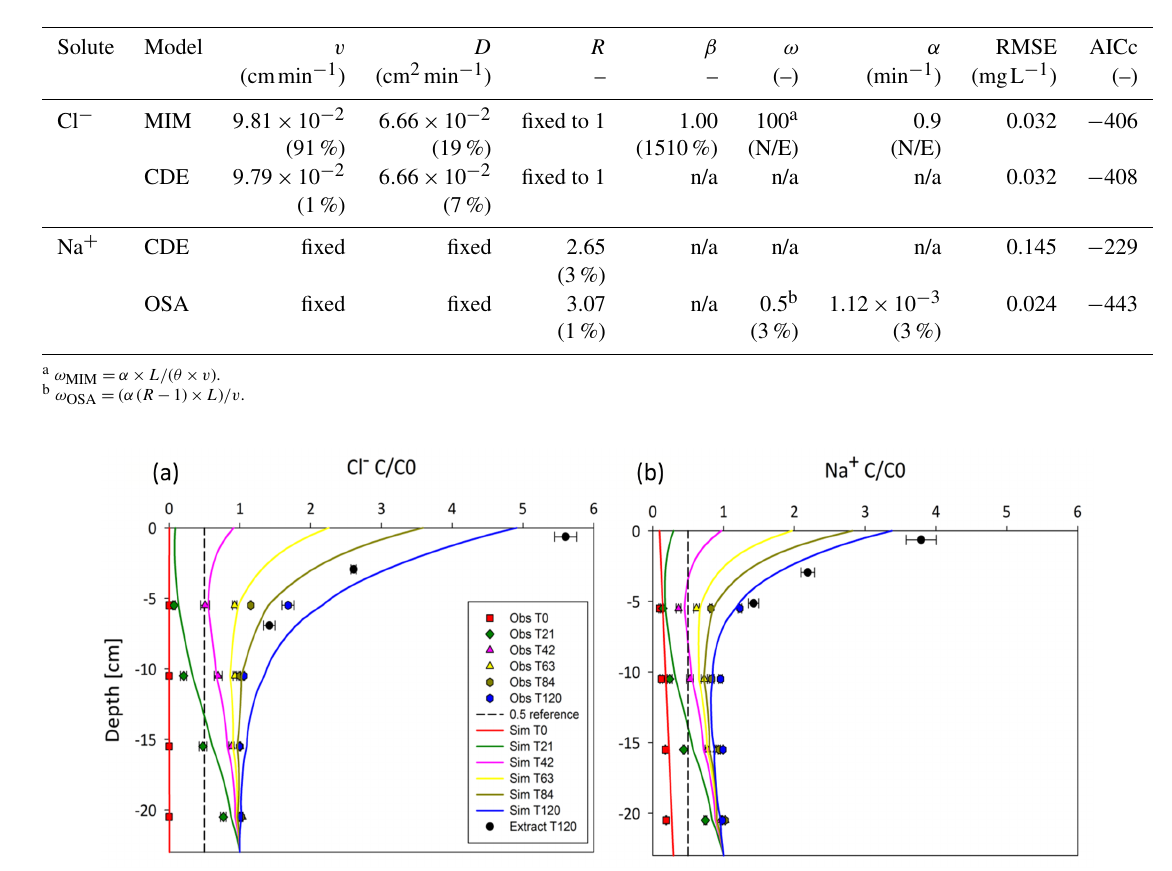
Table 3. Estimated saturated transport parameters and the models’ goodness of fit data. “n/a” – not applicable; N/E – not evaluated: the parameter is at the upper feasible bound of the parameter estimation. Toride et al. (1995) estimated values are presented with coefficient of variation as percentages in brackets; the parameters are explained in the text.